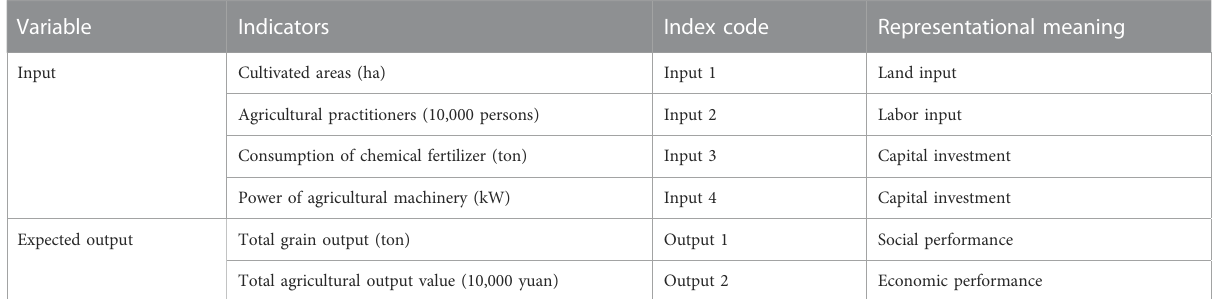
TABLE 2 Evaluation index system of